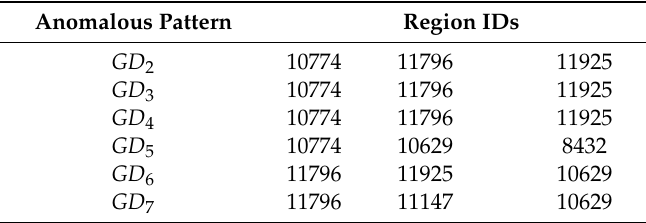
Table 7. Top three regions with the largest mobility increase for each anomalous pattern based on the